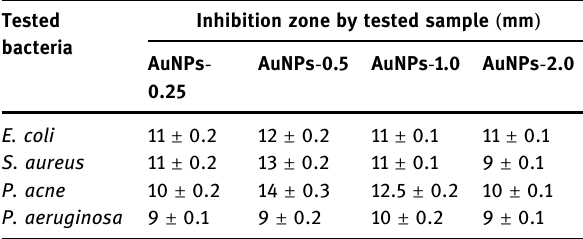
Table 1: Zone of inhibition for antibacterial e ff ect of AuNPs ( tested concentration, 5 μ g · mL − 1 )